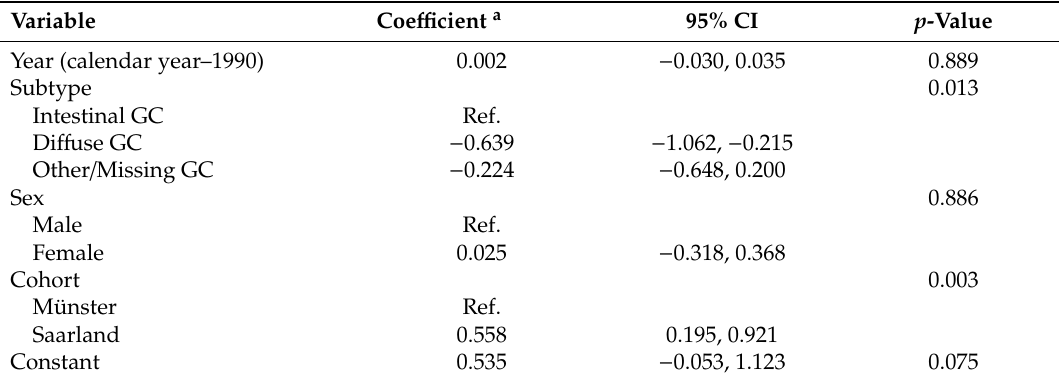
Table 5. Negative binomial regression modeling standardized incidence rate ratios for gastric cancer among resettlers in comparison to the direct host populations in the Münster and Saarland